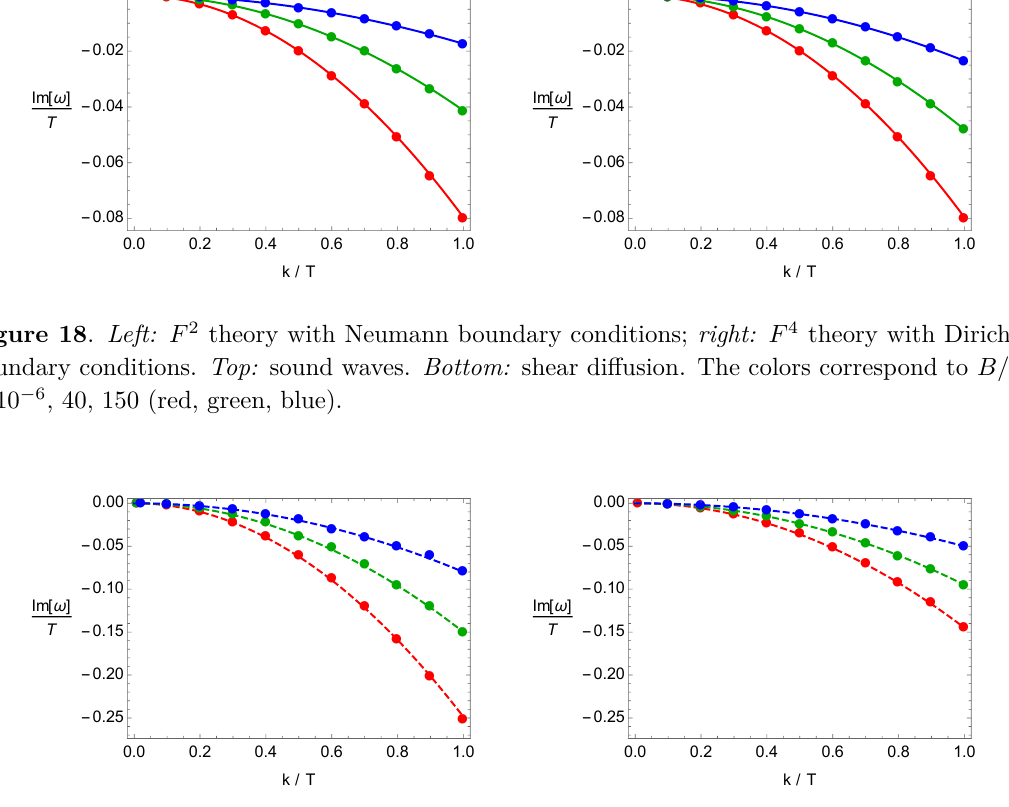
Figure 19 . Left: F 2 theory with Neumann boundary conditions; right: F 4 theory with Dirichlet boundary conditions. Diffusion mode for B/T 2 = 10 − 6 , 40, 150 (red, green, blue). The dashed lines here are not analytic results from magnetohydrodynamics but simply numerical fits to the quasinormal modes